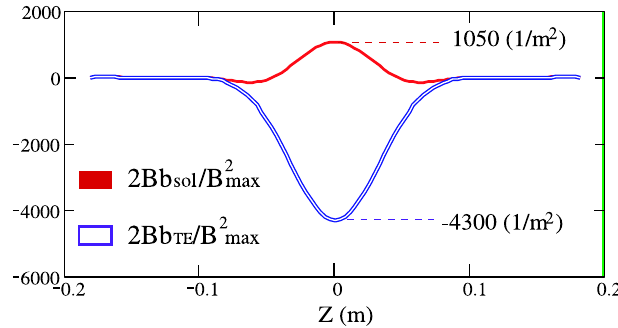
FIG. 7. (Color) Distributions 2 B (cid:1) z (cid:2) b (cid:1) z (cid:2) =B 2 and the static solenoid fields of Fig.